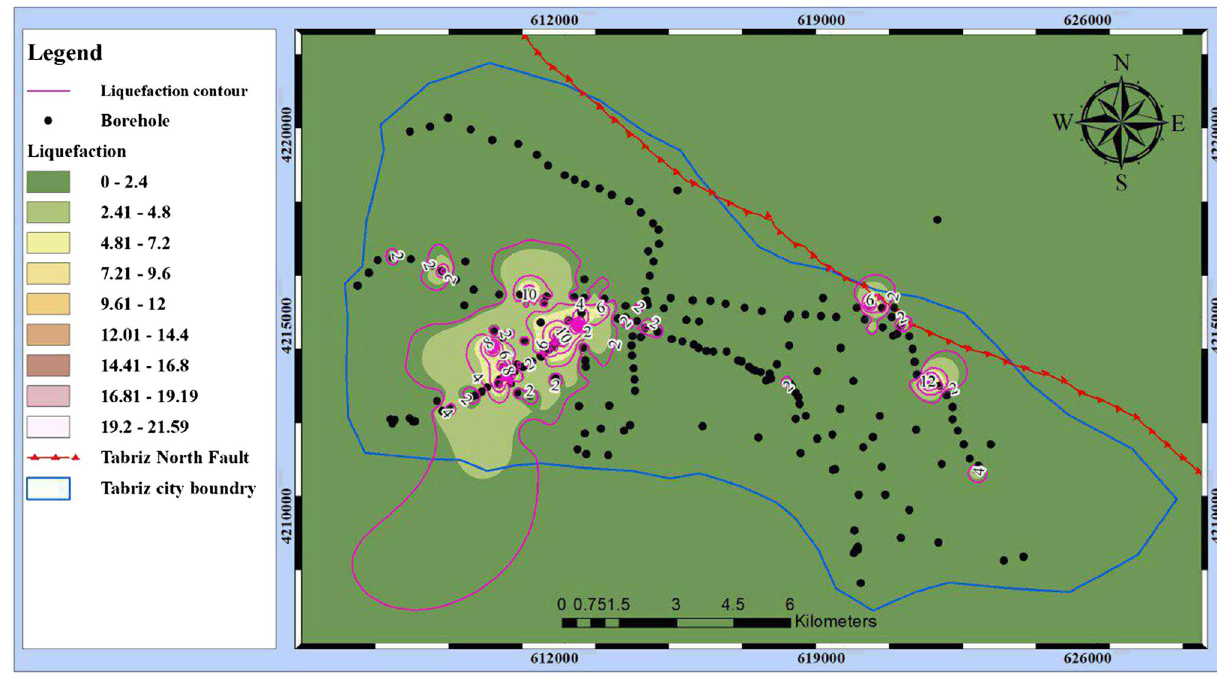
Fig. 10 Zoning map of liquefaction potential Index (LPI) in the study area based on Iwasaki et al.